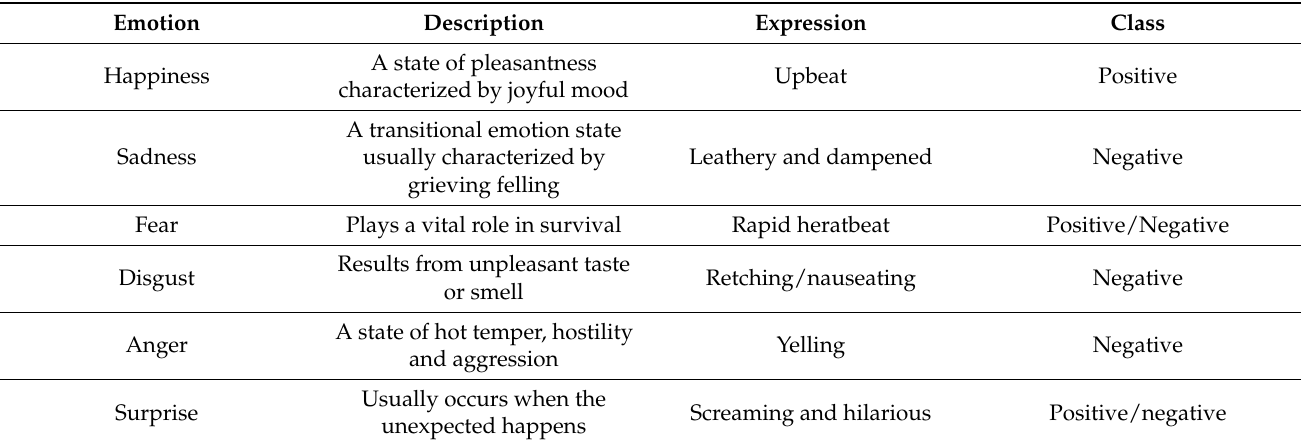
Table 1. Basic Emotion